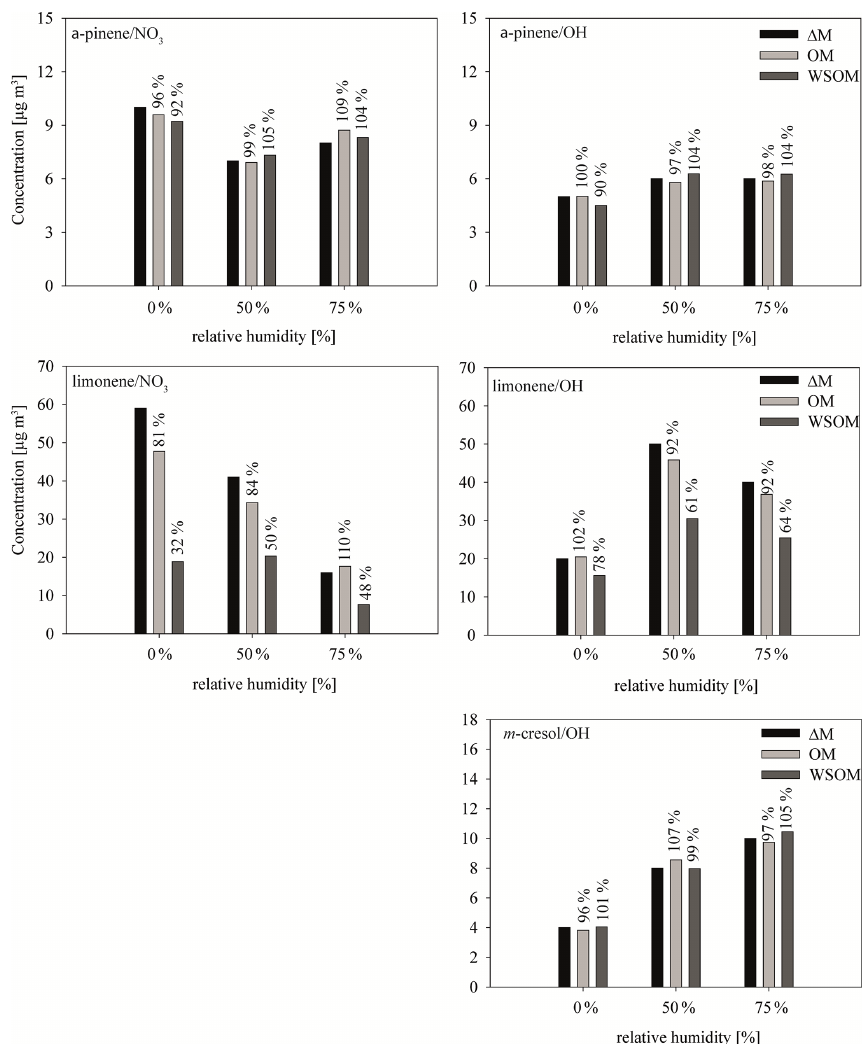
Figure 4. Comparison of organic mass calculated from SMPS with an offline-determined concentration of organic material (OM) and non- purgeable OM. Measurement uncertainties are given as follows: 10% for SMPS measurements (Wiedensohler et al., 2012), 5% for OC / EC measurements (Spindler et al., 2004), and 10% for WSOM measurements (Timonen et al., 2010). Please note that no values can be given for m -cresol / NO 3 as the produced organic mass was too small to be within the detection limits of the different techniques. The values of OM and WSOM were also illustrated as a fraction of the produced organic mass (cid:49) M (expressed as percent above to the corresponding